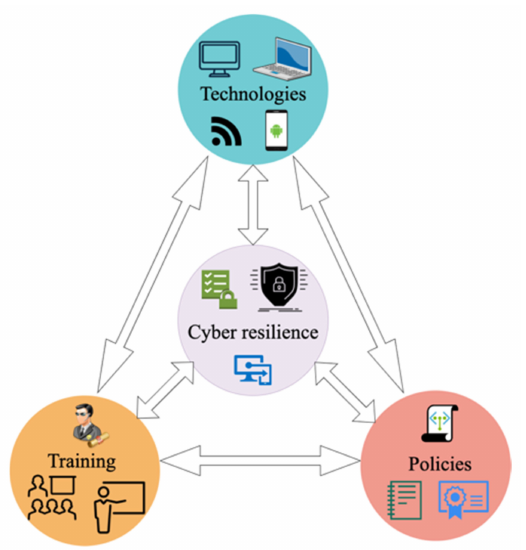
Figure 8. Cybersecurity framework for the digital twin/thread